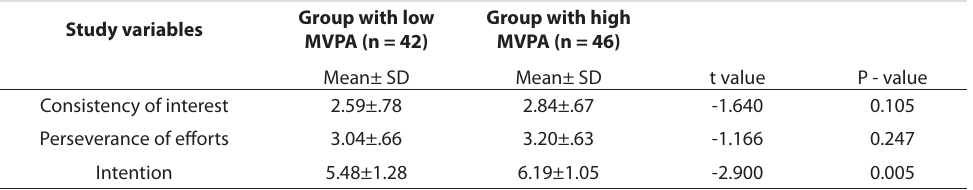
TABLE 4 Mean differences in the grit dimensions and physical activity intention among groups with low and high moderate-to-vigorous physical